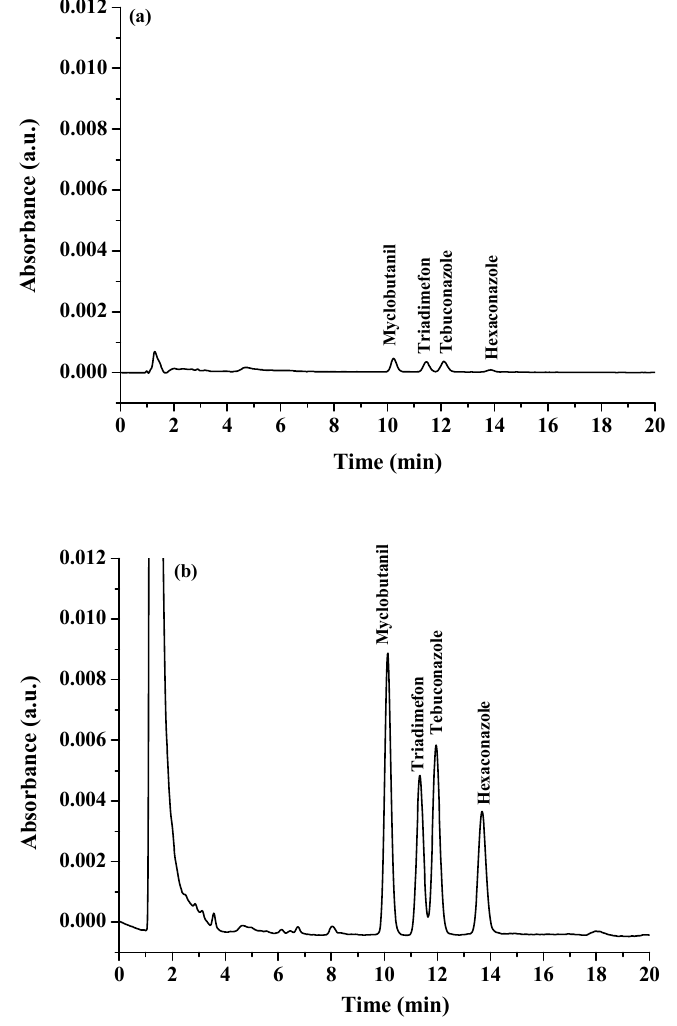
Figure 6. Chromatograms of standard neonicotinoid insecticides obtained ( a ) without preconcentration and ( b ) with preconcentration using the proposed microextraction method; the concentration of all standards was 300 µ g L − 1 .